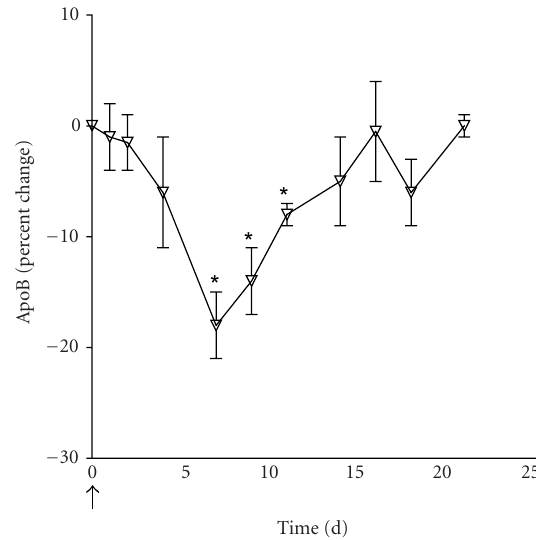
Figure 3. Average percent changes in plasma apoB concentra- tions in cynomolgus monkeys ( ∇ ) after a single injection of the truncated apoC-I peptide at 20mg/kg on day 0 (arrow). Mon- keys were fed the HCHF diet. Values are expressed as mean ± SE, n = 2. Values significantly di ff erent from those at day 0 are marked by an asterisk ( P < . 05).